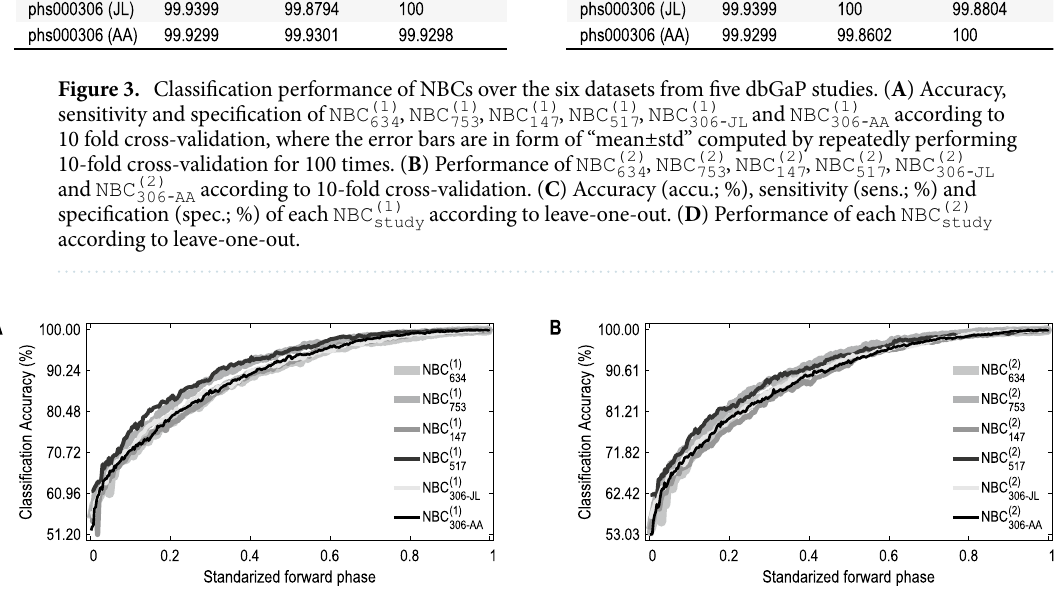
Figure 4. Classification accuracy of NBCs versus the standardized forward phase. Here, the accuracy is that of NBCs in the modeling process, computed according to leave-one-out; the forward phase of OptNBC or SubOptNBC is “standardized” in the sense that “0” and “1” stand for its first and last steps, respectively. ( A ) Results based on OptNBC . ( B ) Results based on SubOptNBC